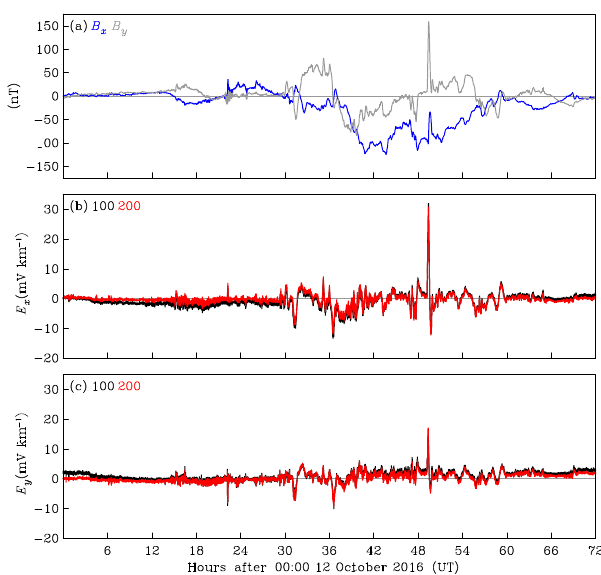
Figure 5. Three days of geomagnetic and geoelectric field varia- tion recorded at the Boulder observatory: (a) north (blue) and east (gray) geomagnetic components; (b) north geoelectric component, 100 (black) and 200 (red) dipole; (c) east geoelectric component, 100 (black) and 200 (red)